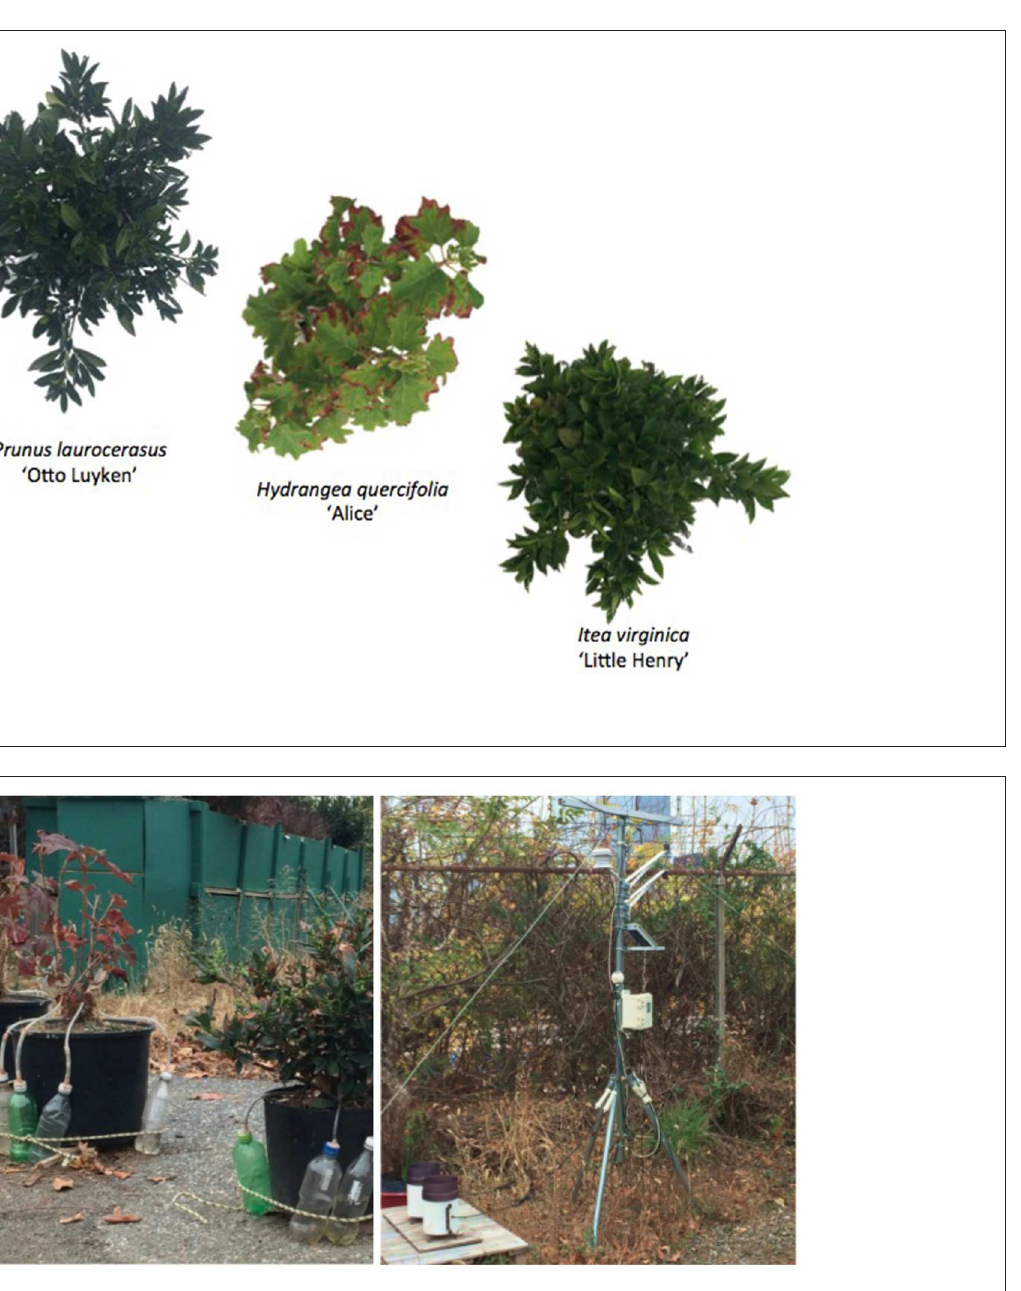
FIGURE 2 | Stemflow collection system (left) and HOBO ® weather station